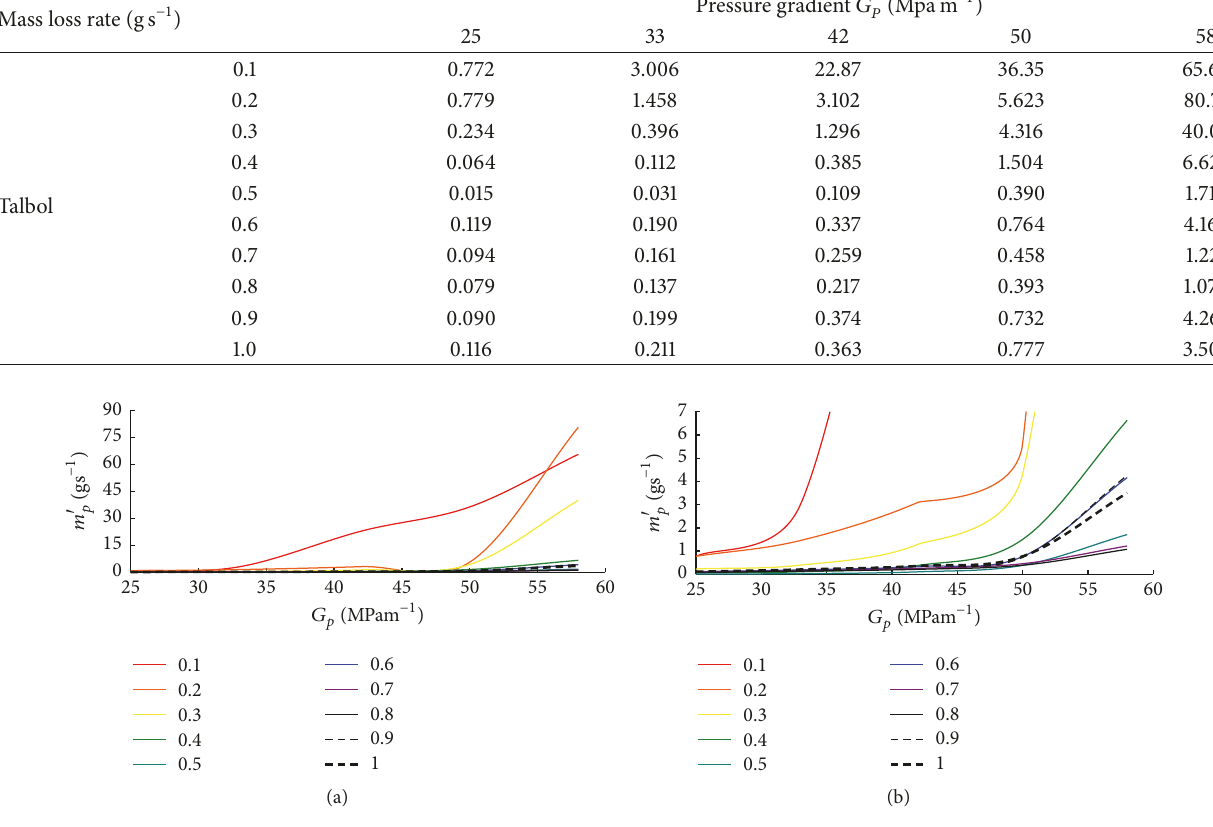
Figure 6: Variation of mass loss rate with pressure gradient.